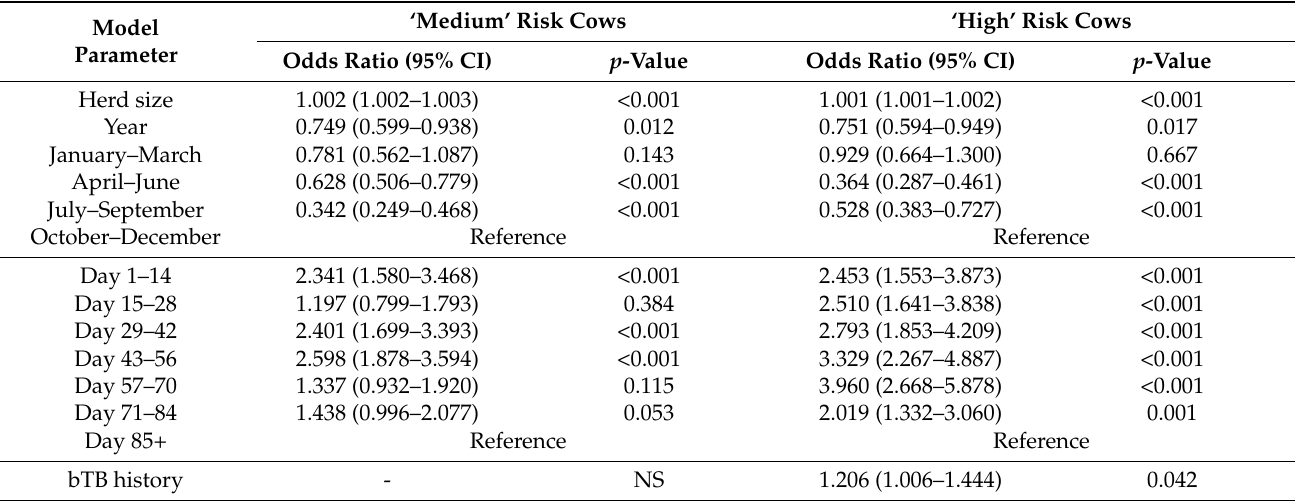
Table 1. Results of the multivariate Poisson regression model of cows testing positive for Johne’s disease using Mycobacterium avium subspecies paratuberculosis milk enzyme-linked immunosorbent